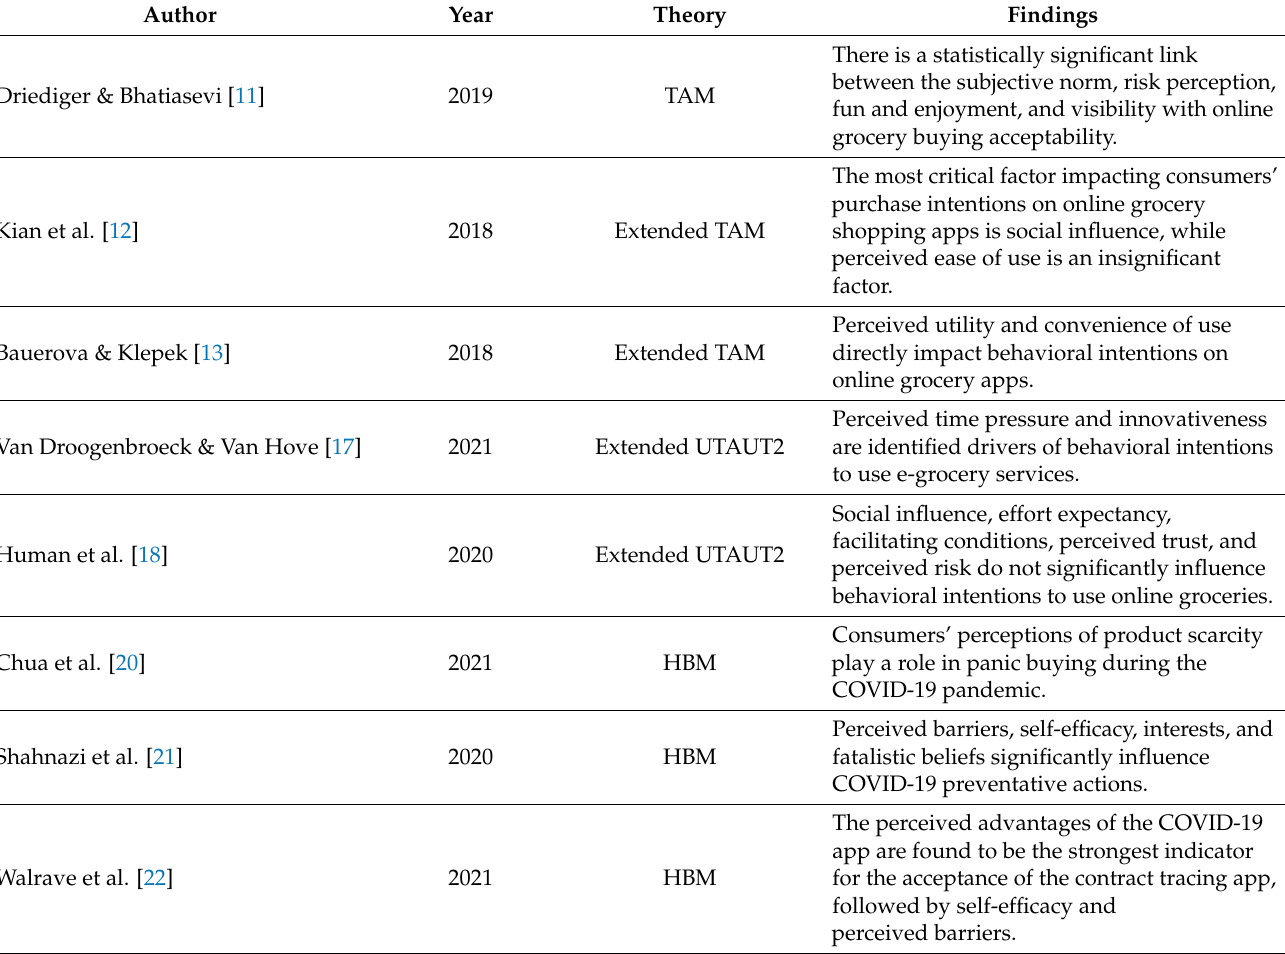
Table 1. The summary of related